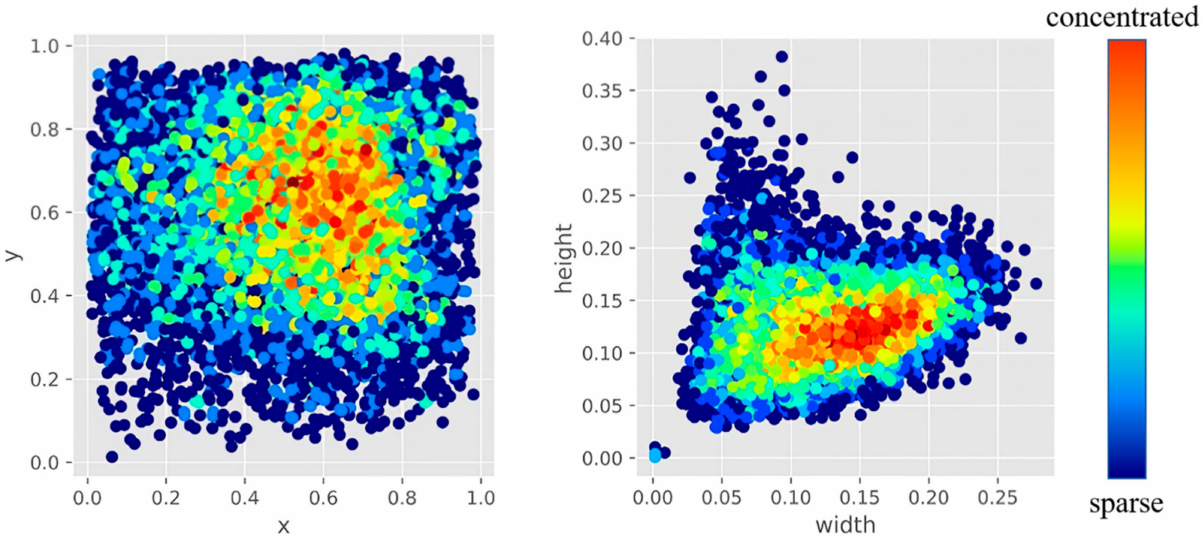
Figure 1. Analysis of crucian carp dataset. This figure is a heat map of the x, y, and width, height of the crucian carp image. The darker the color, the stronger the concentration, and the denser the distribution of crucian carp.